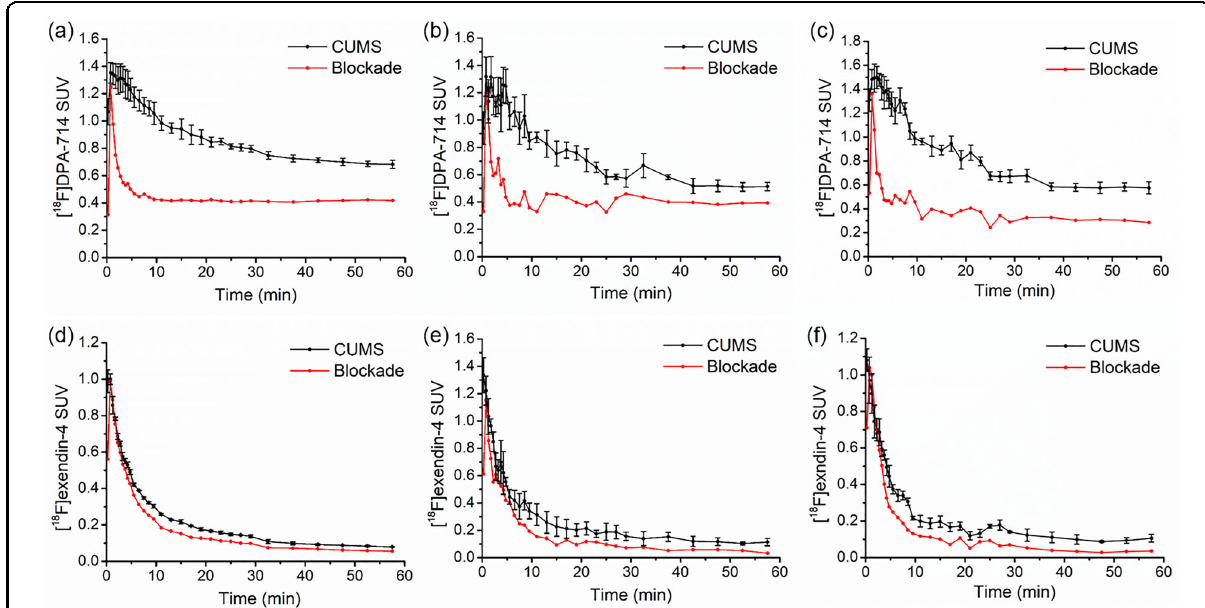
Fig. 2 Dynamic PET analysis and blocking experiments of [ 18 F]DPA-714 and [ 18 F]exendin-4 in the brain of depressive rats. Time-activity curves of [ 18 F]DPA-714 uptake in whole brain ( a ), posterior hippocampus ( b ), and medial prefrontal cortex ( c ). Time-activity curves of [ 18 F]exendin-4 uptake in whole brain ( d ), hypothalamus ( e ), and ventral tegmental area ( f ). n = 4 for each group of dynamic experiments and n = 1 for each group of blocking